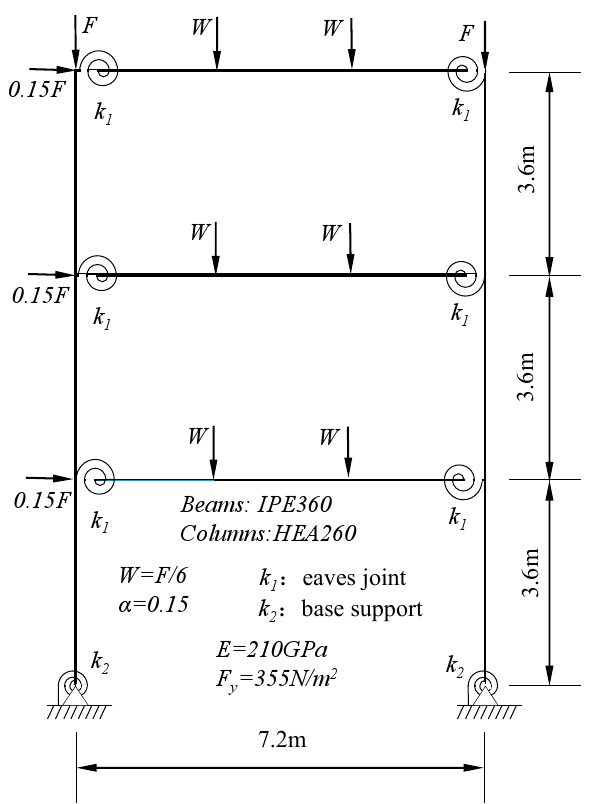
Figure 17. A single-span three-story steel portal frame with semi-rigid connections and supports.